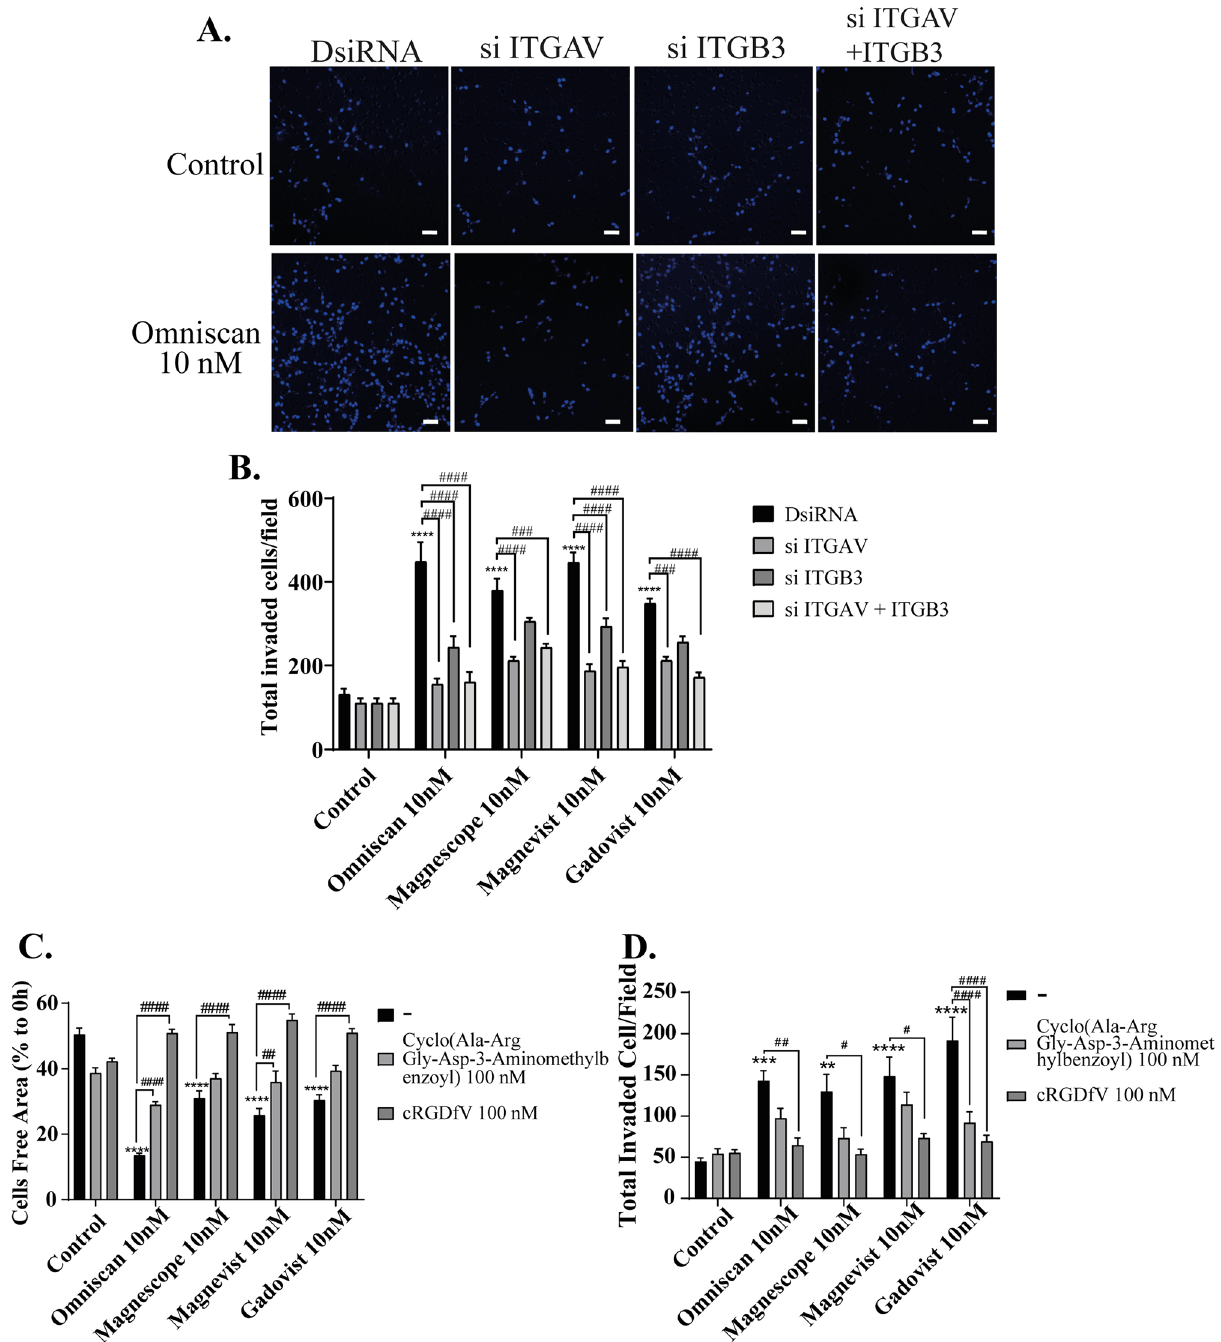
Figure 3. GBCAs increased astrocyte migration via integrin αvβ3. ( A ) Representative photomicrographs showing the effects of GBCAs after knockdown of ITGAV, ITGB3, or ITGAV and B3 on 3D matrigel invasion assays using astrocytes. Quantitative analysis of the effect of GBCAs after knockdown of ITGAV, ITGB3, or ITGAV and B3 on cell invasion ( B ) or coexposure with integrin inhibitor on wound healing assay ( C ) or cell invasion assays ( D ). The total number of cells was quantified using ImageJ software (NIH). Bars represent 50 μm. Data are expressed as the mean ± SEM of at least three independent experiments. **** p < 0.0001, *** p < 0.001, ** p < 0.01, indicates statistical significance were analysed by two-way ANOVA continued with post hoc Bonferroni’s or Turkey test compared with the control. #### p < 0.0001, ### p < 0.001, ## p < 0.01, # p < 0.05, indicates statistical significance were analysed by two-way ANOVA continued with post hoc Bonferroni’s or